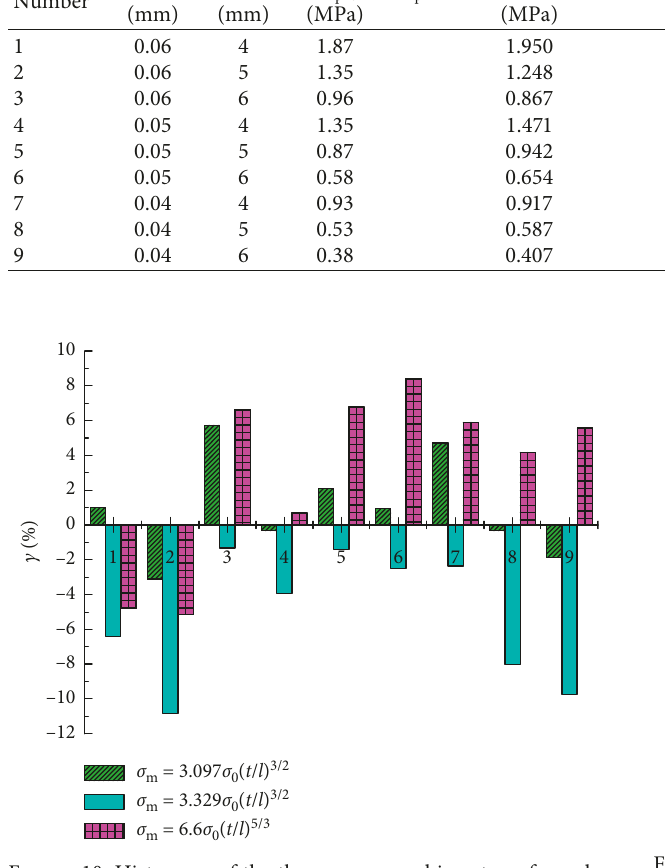
Figure 10: Histogram of the three mean crushing stress formulas with nine experimental deviations.